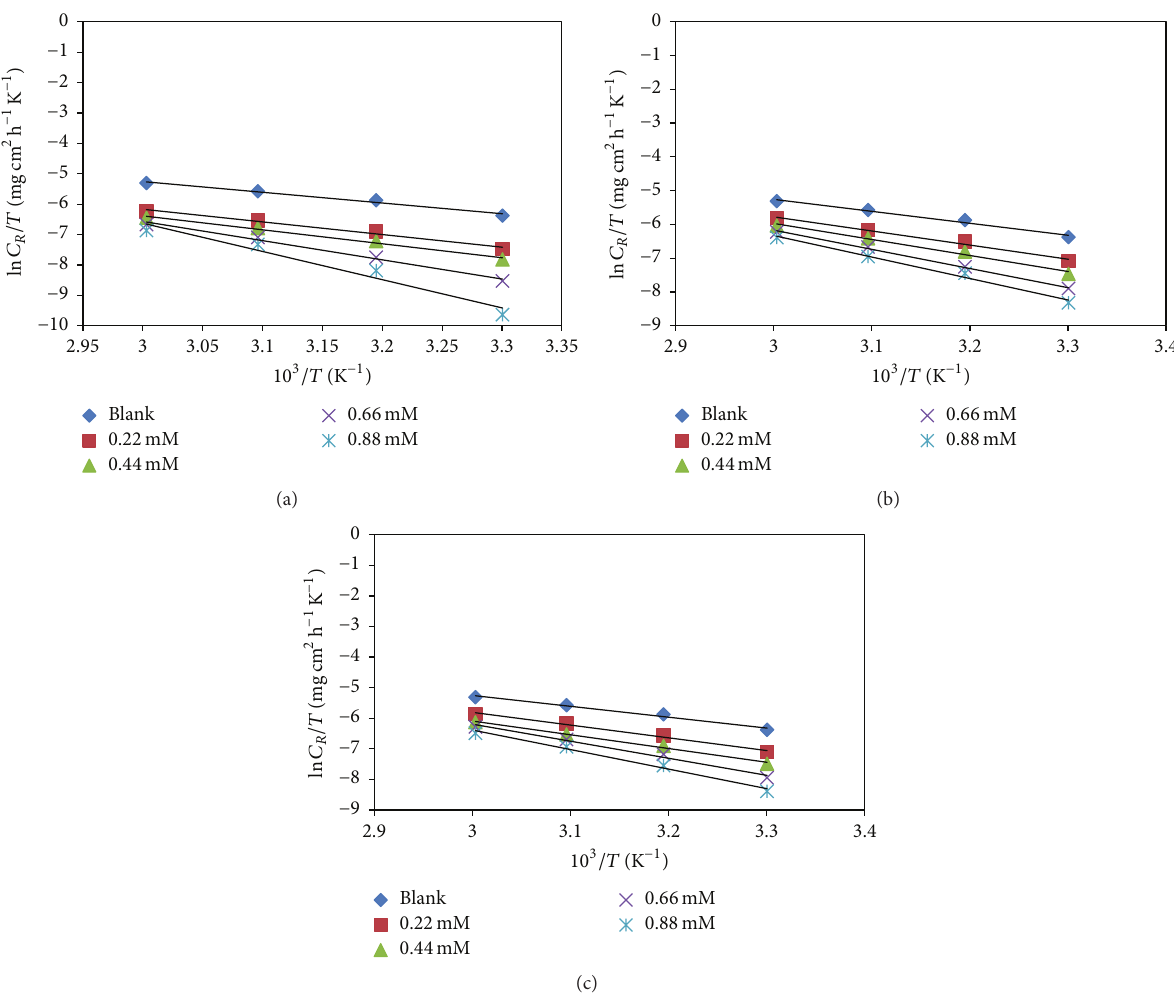
Figure 3: Alternative Arrhenius plots in the absence and presence of different concentrations of (a) 2-MTPH, (b) 3-MTPH, and (c) 4-MTPH.